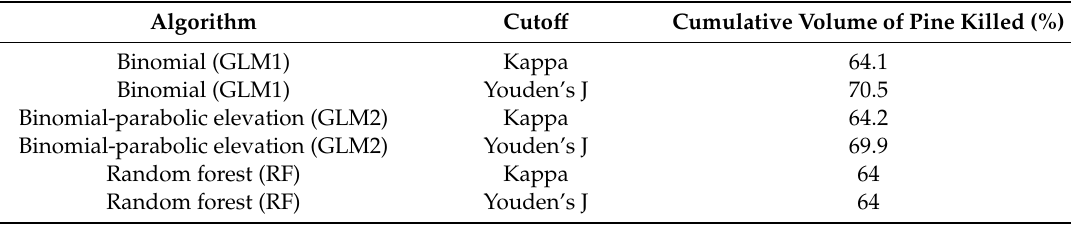
Table 4. Estimates of cumulative percentages of pine volume killed in MPB attacks by 2020 for three